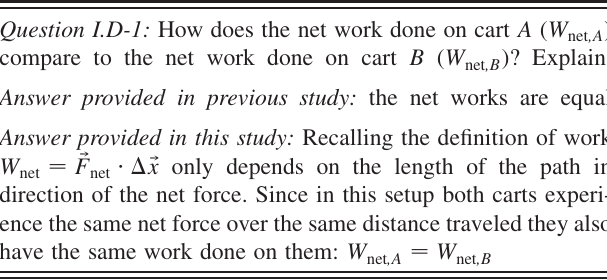
TABLE IV. Representative sample of tutorial question and corresponding answer key from the two studies.